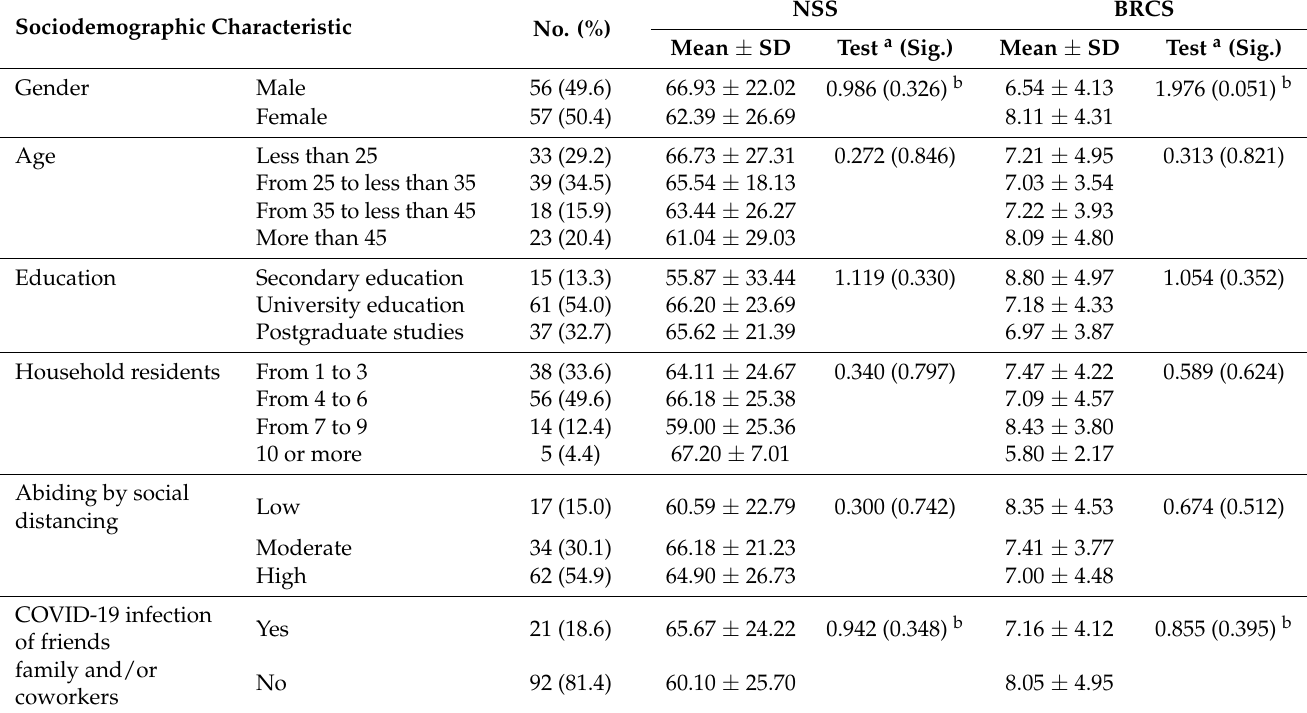
Table 1. Sociodemographic Characteristics’ Frequencies and Relation with Nursing Stress Scale (NSS) and Brief Resilience Coping Scale (BRCS) among Studied Sample. ( n = 113).